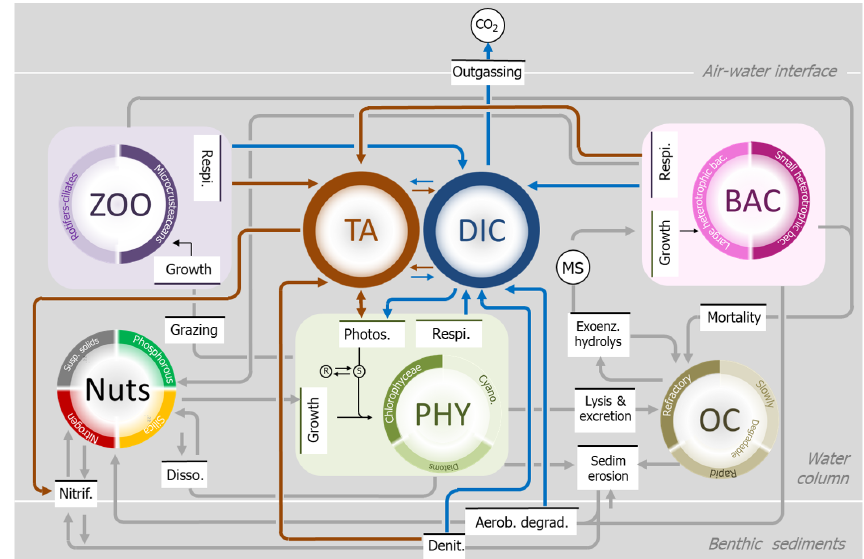
Figure 2. Schematic representation of the ecological RIVE model (initially developed by Billen et al., 1994, and Garnier and Billen, 1994), with gray lines indicating the main processes simulated in the water column and at the interface with sediment (oxygen not shown), and implementation of the new inorganic module, based on total alkalinity (TA, maroon) and dissolved inorganic carbon (DIC, blue). Table 2. Stoichiometry of the biogeochemical processes, influencing dissolved inorganic carbon (DIC) and total alkalinity (TA) in freshwater, as taken into account in the new inorganic carbon module. TA and DIC expressed in mol:mol of the main substrate (either C or N). Processes Equations DIC TA Eq. FCO